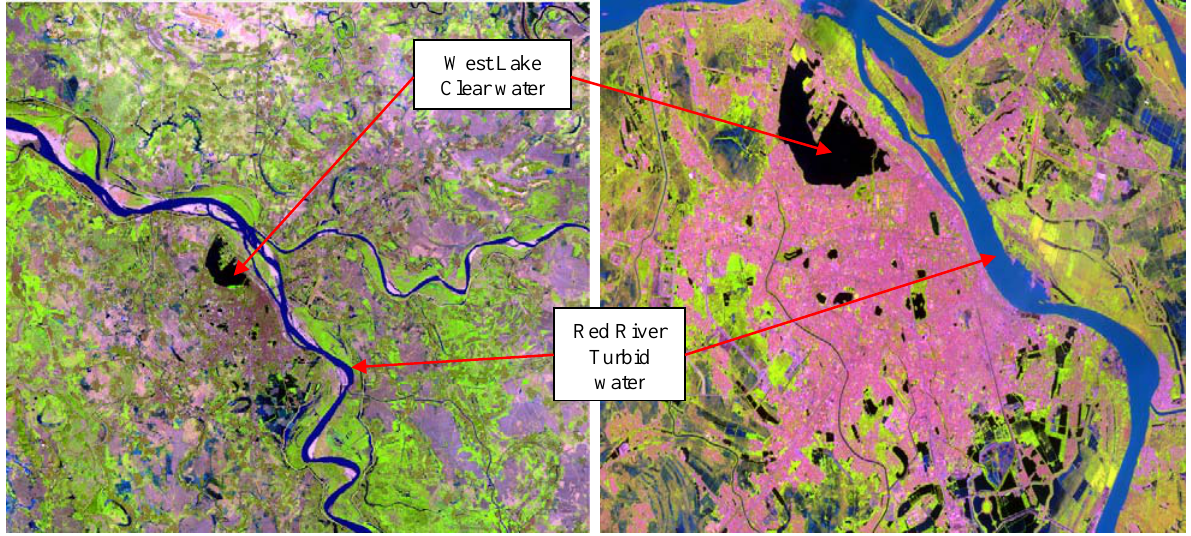
Figure 2. Study area by Landsat 5 TM (left) and Spot 5